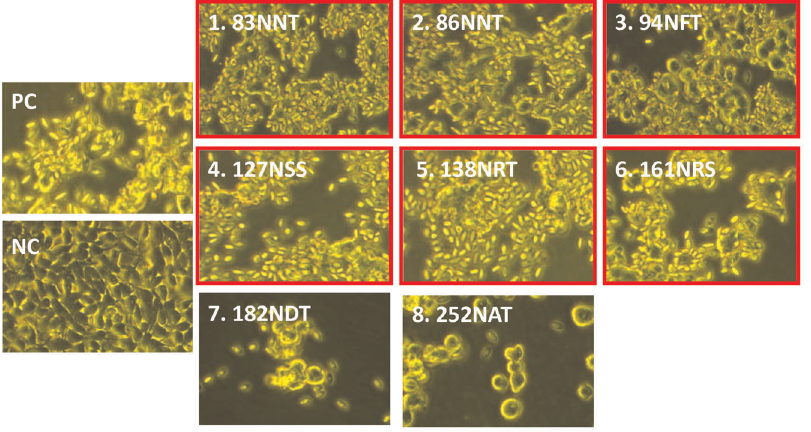
Figure 5. Hemadsorption assay. RBCs were added to 293 cells transfected with mutated DNA-HA vectors to cover cell monolayer. Results for RBC adsorption indicate that cells transfected with the 83NNT, 86NNT, 94NFT, 127NSS, 138NRT and 161NRS vectors retained their hemadsorption function, while cells transfected with the 156NTT, 183NDT and 252NAT vectors did not. Cells transfected with a wild-type DNA-HA vector were used as a positive control (PC); cells tranfected with an empty vector were used as a negative control